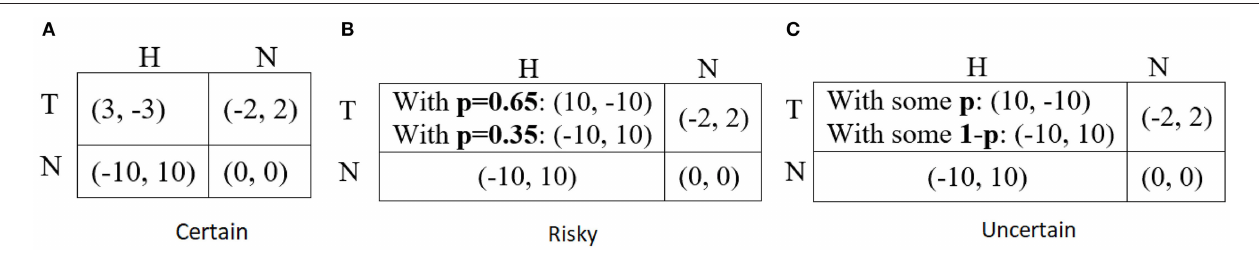
FIGURE 2 | Asymmetric security game in various conditions with x = z = 10, y = 2, and probability p = 0.35. (A) Shows the certain condition in which participants have complete information about all possible outcomes. (B) Shows the risky condition in which participants receive explicit probabilities of possible outcomes. (C) Shows the uncertain condition in which participants are not informed about the values of the probability p.